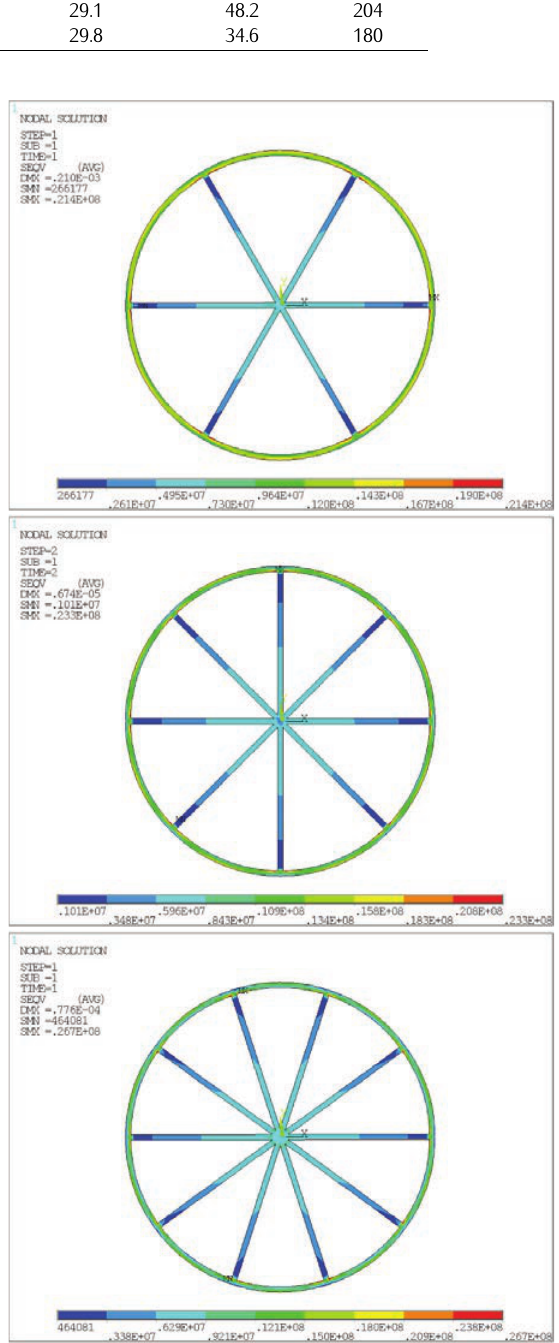
Figure 5. Plane stress distribution for flywheel pattern impellers The 2-D analysis is further extended for the same tip speed of 100 m/s and maximum stresses are found out at different mean radius to thickness r m / t ratios (Fig. 6). The analysis reveals that when tip speed is kept constant at the mean radius, the maximum stresses only